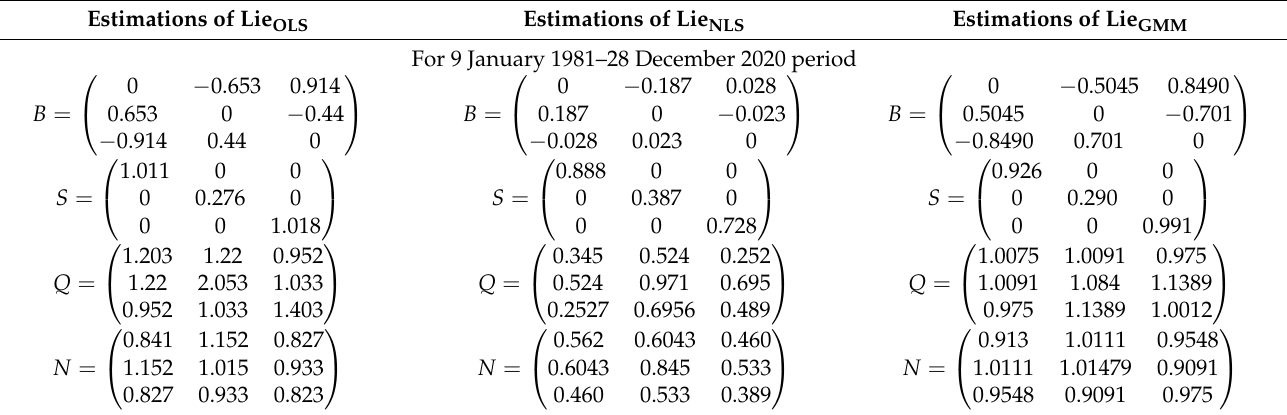
Table 4. Estimations of Lie parameters with OLS, NLS, and GMM methods *. Estimations of Lie